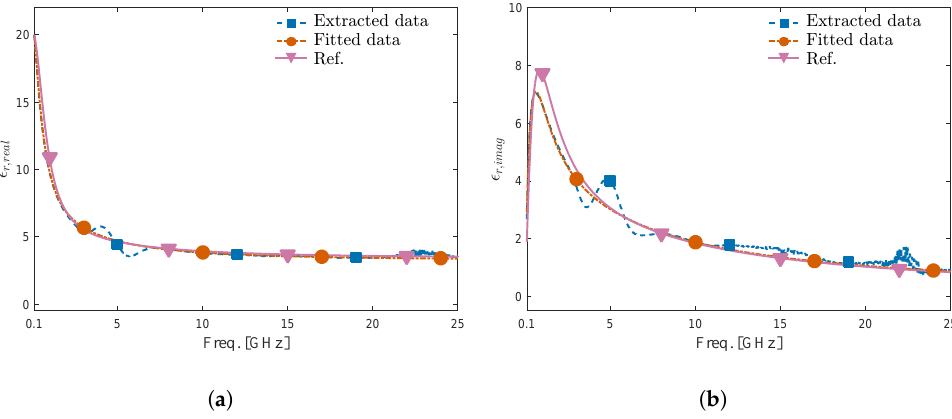
Figure 8. Extracted and fitted permittivity using IDC with an electrode width of 2 µ m compared with reference permittivity for DI water/IPA Mixture with IPA volume fraction 80%. ( a ) Real part. ( b ) Imaginary